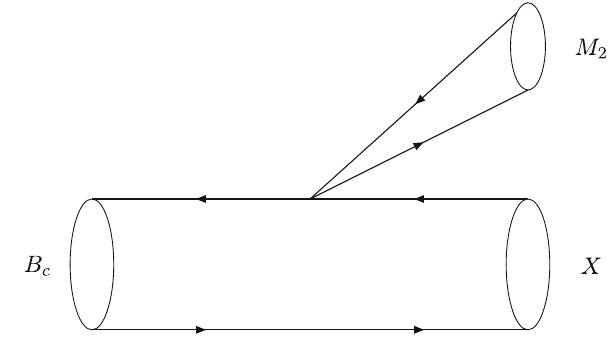
Fig. 2 Feynman diagram of the nonleptonic decay B c → XM 2 , X denote Z ( 3930 ) or X ( 4160 ) , M 2 denote a light meson: π, K ,ρ, or K